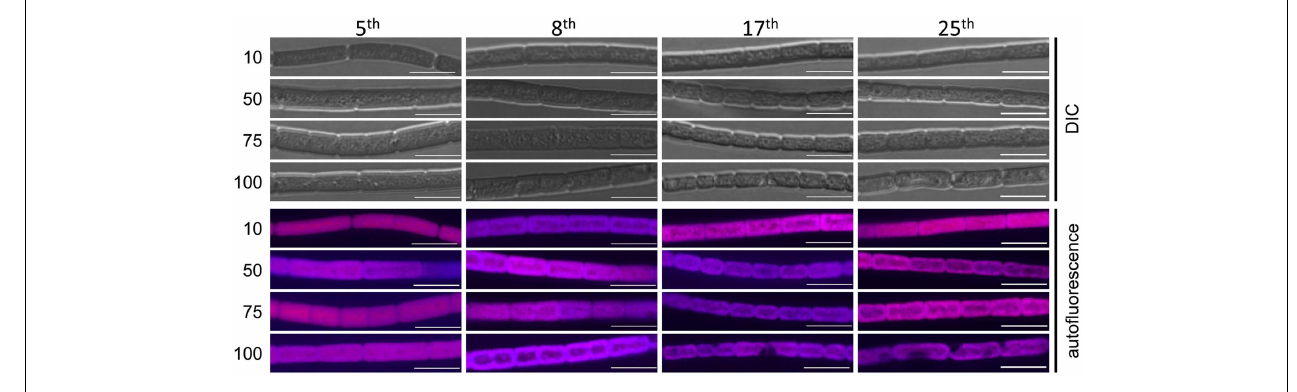
optical slices from a Z-series of differential interference contrast (DIC) images (upper half) and maximum intensity projection of phycobiliprotein autofluorescence images (lower half) ofWT. Numbers of consecutive dilutions (5, 8, 17, or 25) made before imaging are indicated at the top of each column. All images were acquired with a 40 × oil objective with 2 × zoom. Bar represents 10 μ m.